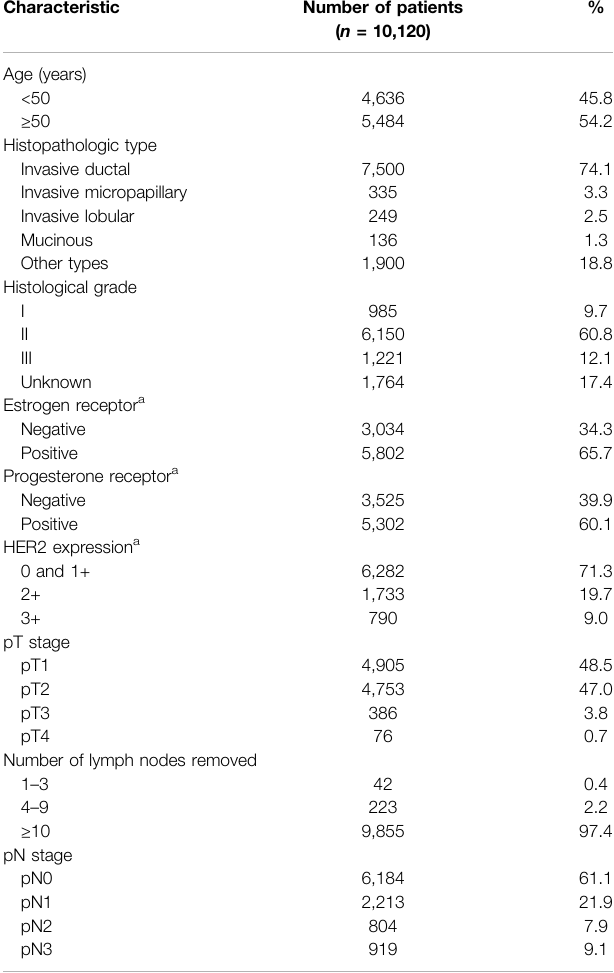
TABLE 1 | Clinicopathologic characteristics of breast cancer patients in the TCIH database ( n = 10,120).